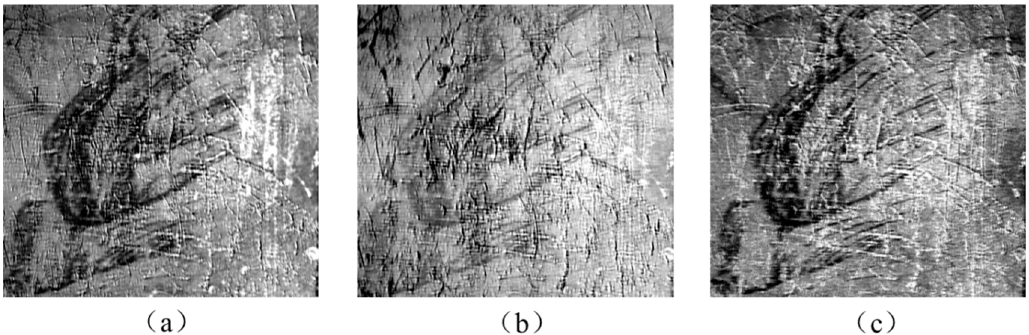
Figure 11. The enhancement results of area 1 with different methods. ( a ) Enhancement results of the method in this paper; ( b ) the second band of principal component analysis (PCA) transform; ( c ) the fifth band of independent component analysis (ICA) transform.